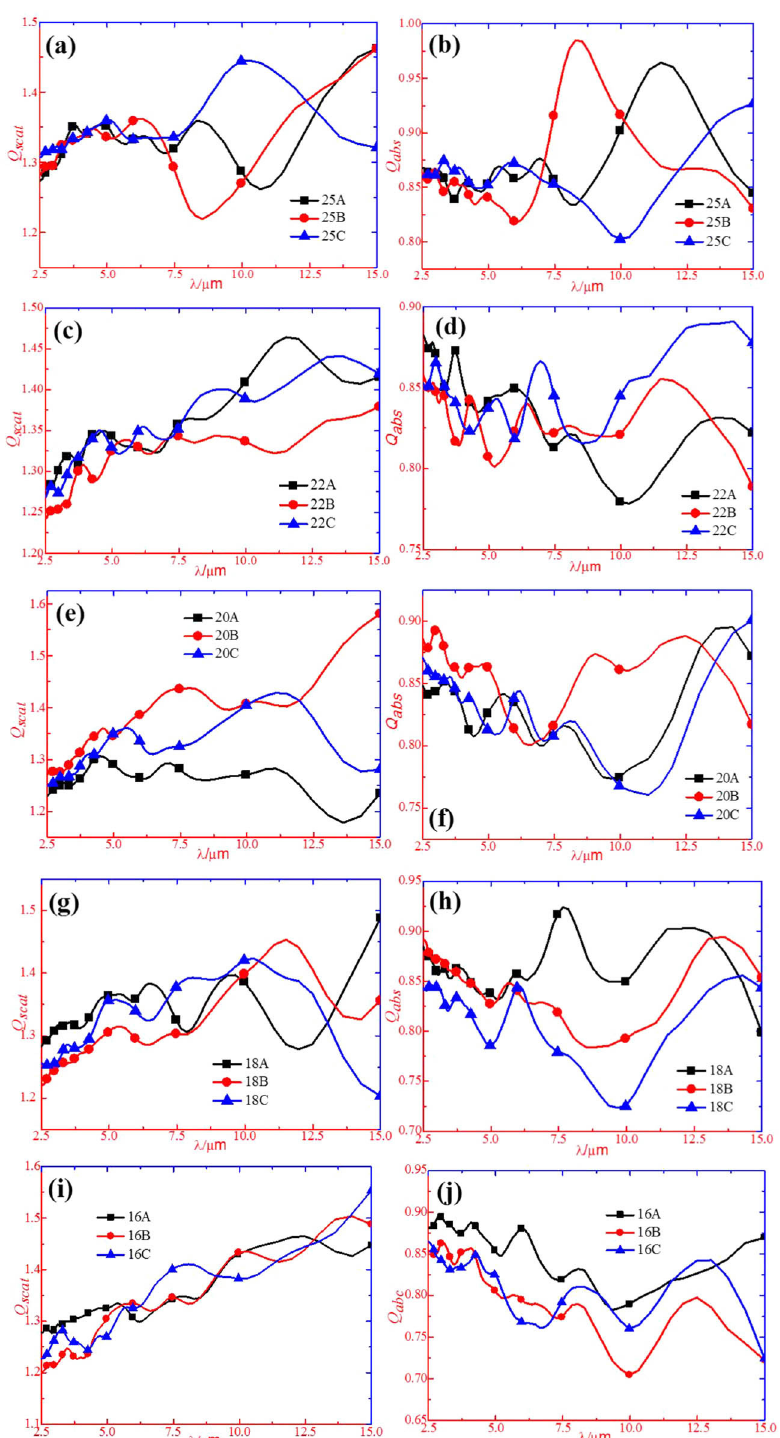
Figure 4: Scattering and absorption factors of 2D random arrangements of carbon nano fi ber with various numbers: ( a ) 25, ( b ) 25, ( c ) 22, ( d ) 22, ( e ) 20, ( f ) 20, ( g ) 18, ( h ) 18, ( i ) 16 and ( j )